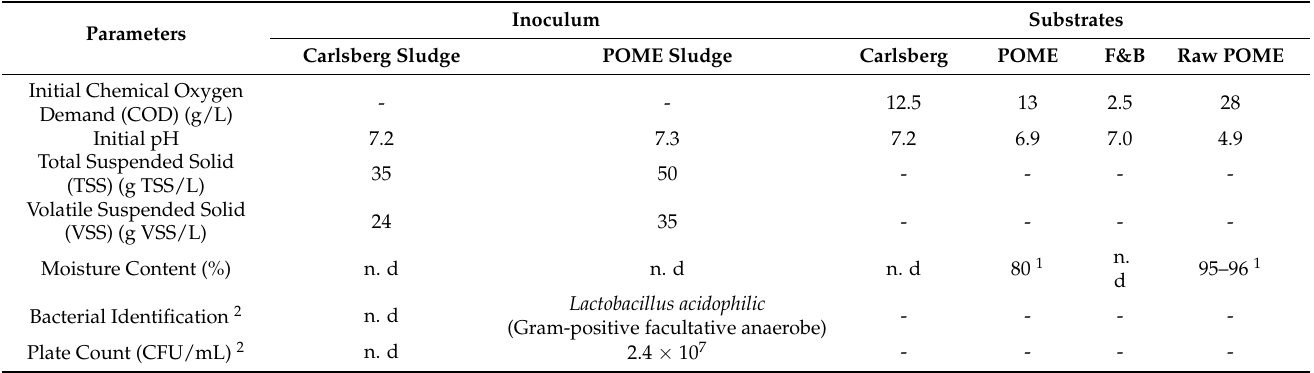
Table 1. Characteristics of the inoculums and substrates used in this